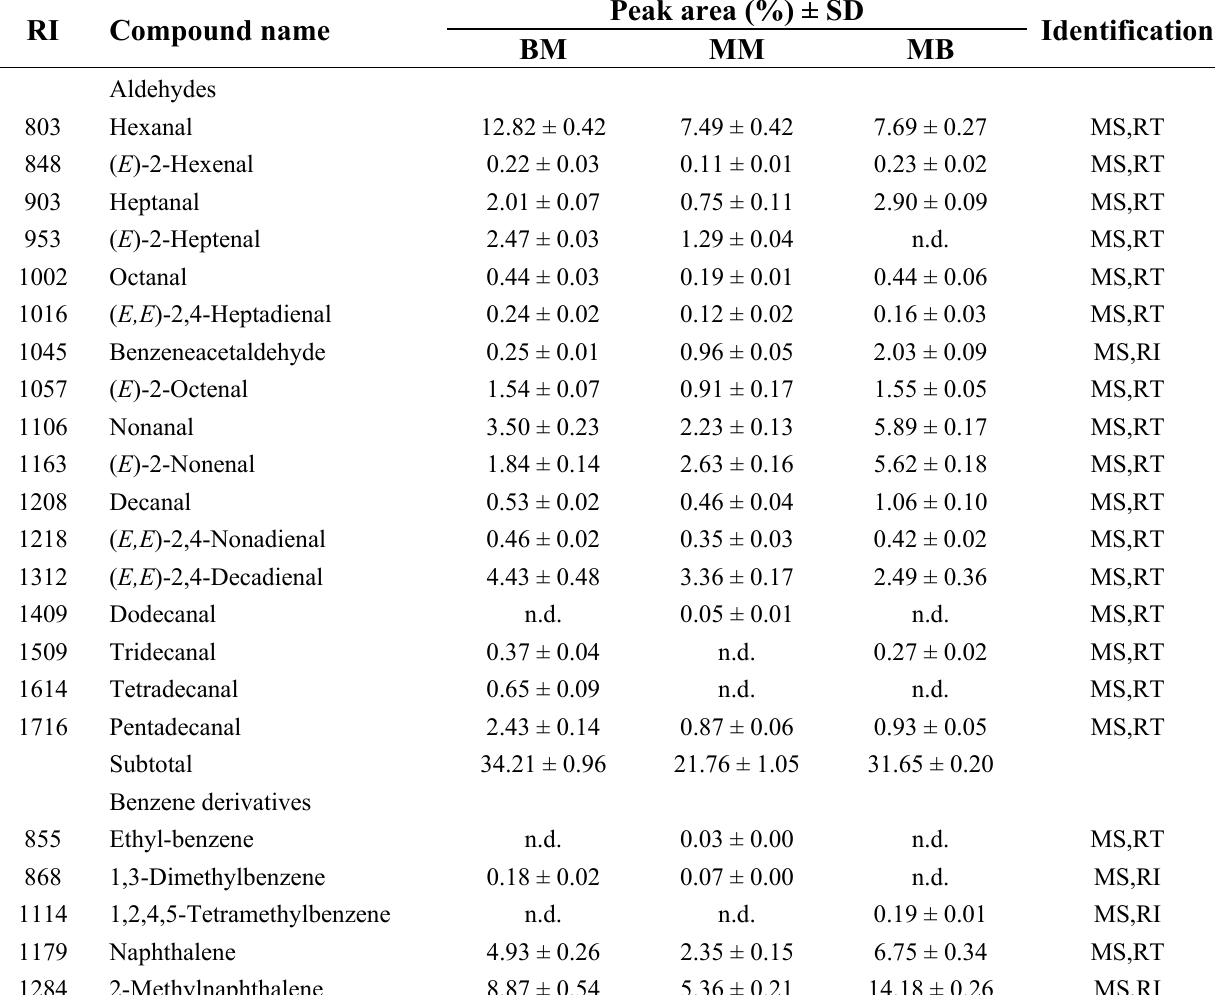
Table 1. Volatile components identified in BM, MM and